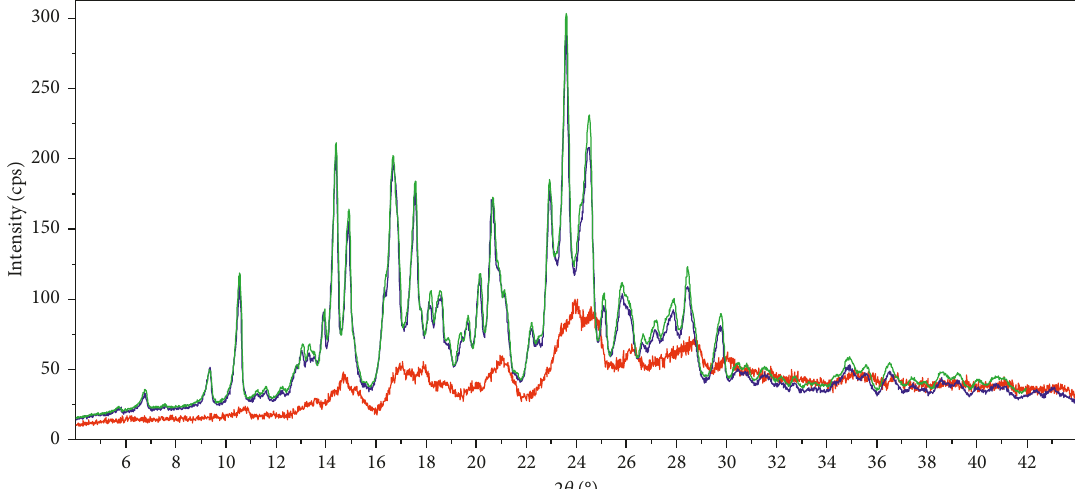
Figure 1: Powder XRD profiles of a diastereomeric salt sample, showing the open air drying process starting from its wet state during repeated diffraction measurement series with prolonged measurement time in open air.